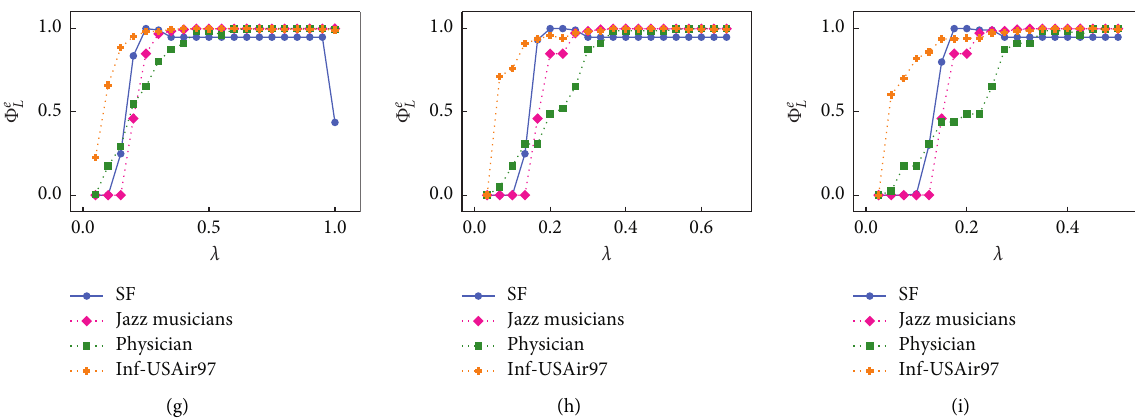
Figure 5: Structural properties of the optimal latent edge L scored by influence indicator δ . The normalized latent edge rank Φ d scored by the degree centrality product θ d of the optimal latent edge L on network SF (blue circles), Jazz musicians (pink diamonds), physician (green squares), and inf-USAir97 (orange plus) when the cooperativity parameter (a) β � 1, (b) β � 1 . 5, and (c) β � 1 . 5. The corresponding results of the normalized latent edge rank Φ b scored by the betweenness centrality product θ b and normalized latent edge rank Φ e scored by the eigenvector centrality product θ e are shown in (d) β � 1, (e) β � 1 . 5, and (f) β � 1 . 5 and (g) β � 1, (h) β � 1 . 5, and (i) β � 1 . 5,